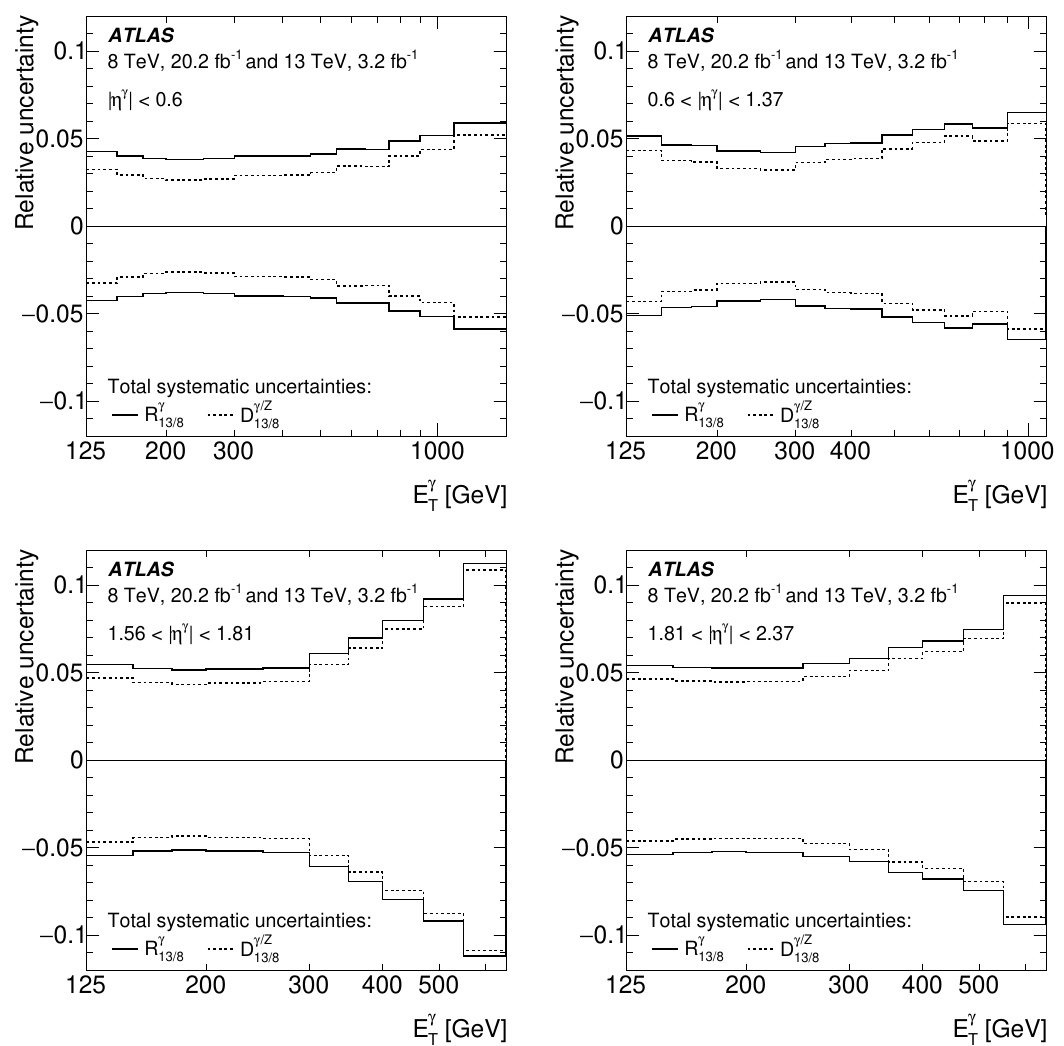
Figure 5 . Relative total systematic uncertainty in R (cid:13) as functions of E (cid:13) for di(cid:11)erent (cid:17) (cid:13) T